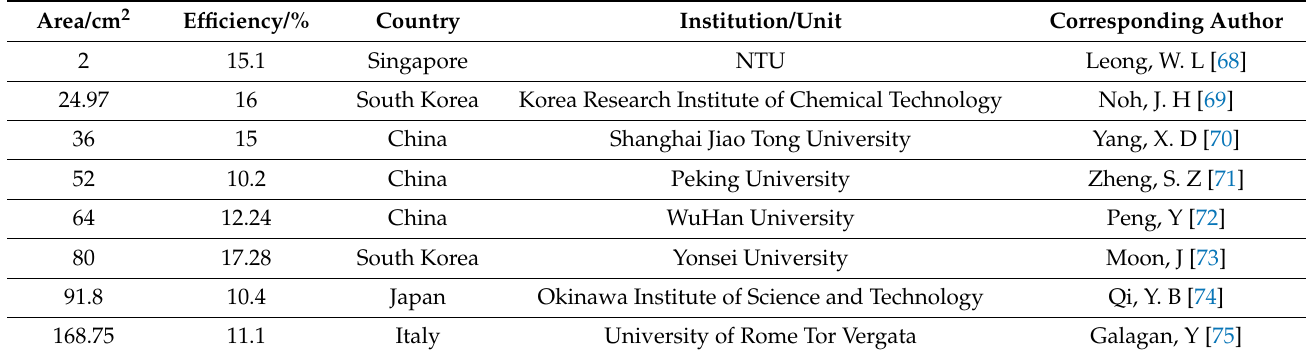
Figure 7. The changing trend of PCE and area of large-area PSCs from 2015 to 2020. Table 1. A list of some excellent works on large-area PSCs.